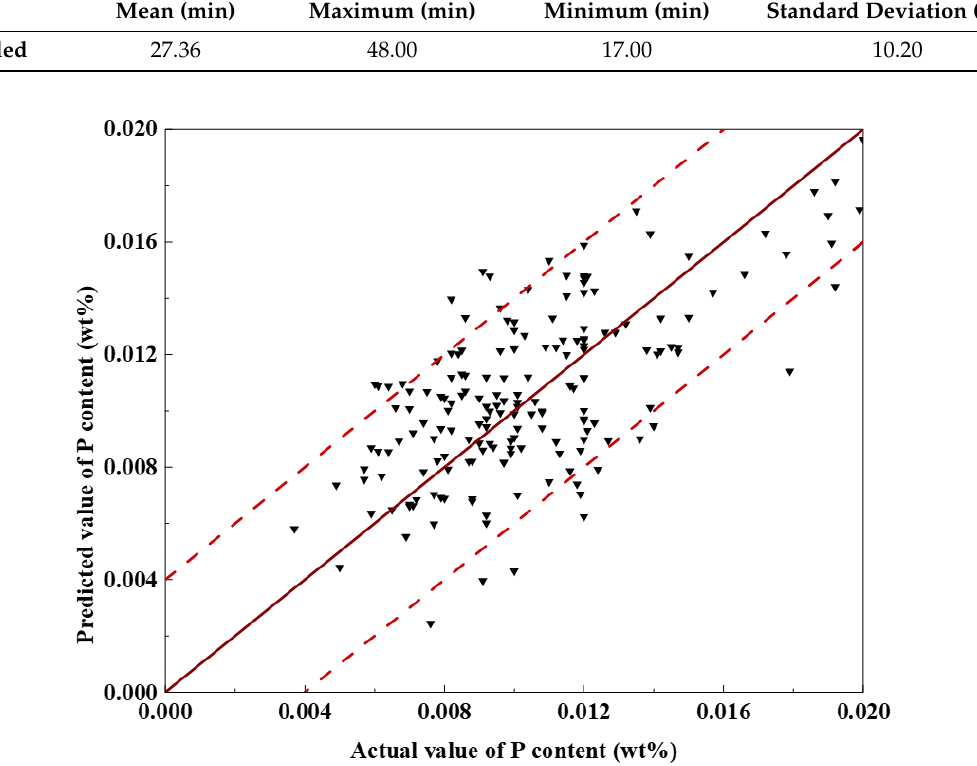
Figure 10. Results of the prediction model optimized with time of the first addition of lime.